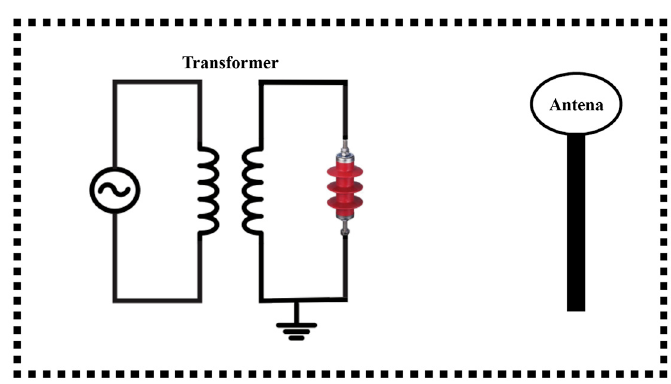
Figure 4. Electromagnetic emission setup.